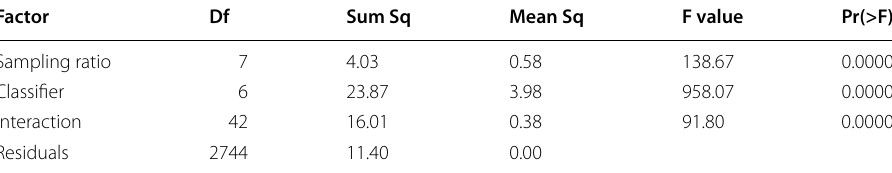
Table 18 ANOVA results for 2-factor test of classifier and sampling ratio, including their interaction; in terms of AUPRC Factor Df Sum Sq Mean Sq F value Pr(>F) Sampling ratio 7 4.03 0.58 138.67 0.0000 Classifier 6 23.87 3.98 958.07 0.0000 Interaction 42 16.01 0.38 91.80 0.0000 Residuals 2744 11.40 0.00